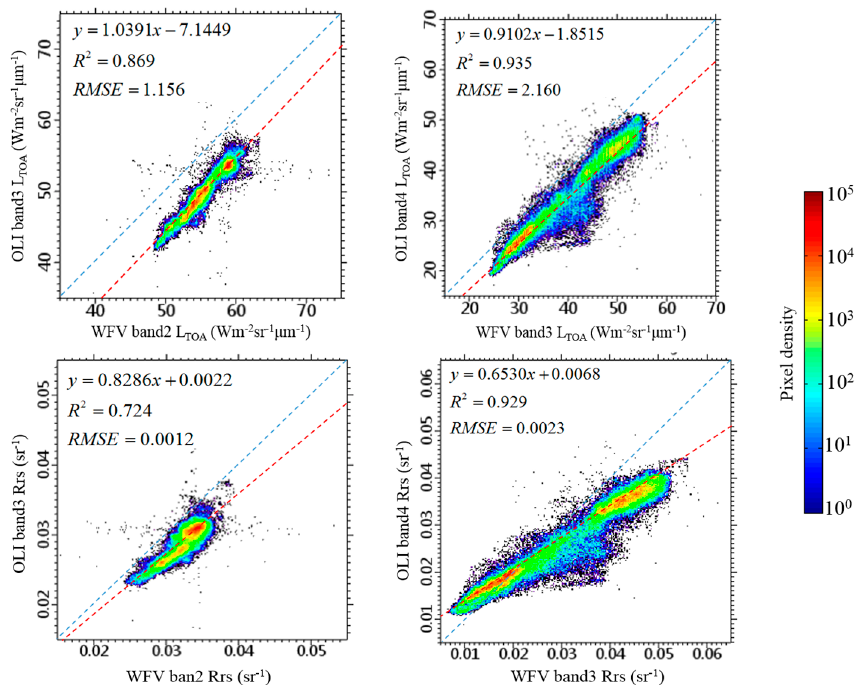
Figure 8. Comparison between WFV’s and OLI’s L TOA (upper two figures) together with R rs (lower two figures) of corresponding pixels ( N = 4,465,514) at green (band 2 for WFV, band 3 for OLI) and red (band 3 for WFV, band 4 for OLI) band. Pixels are within region-of-interests for sampling (three dashed black box in Figure 4a). Colors denote pixel densities, the dashed red line is the regression line and the dashed blue line is the 1:1 line.